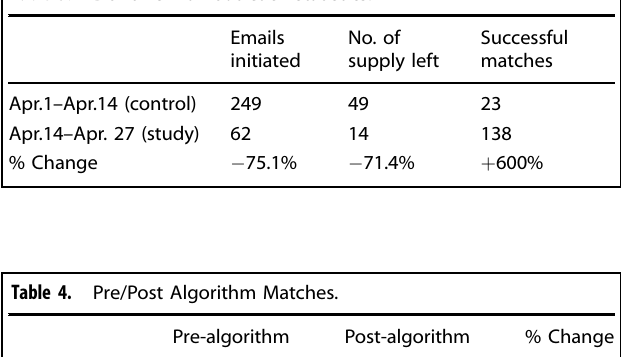
Table 3. Donor e-mail outreach